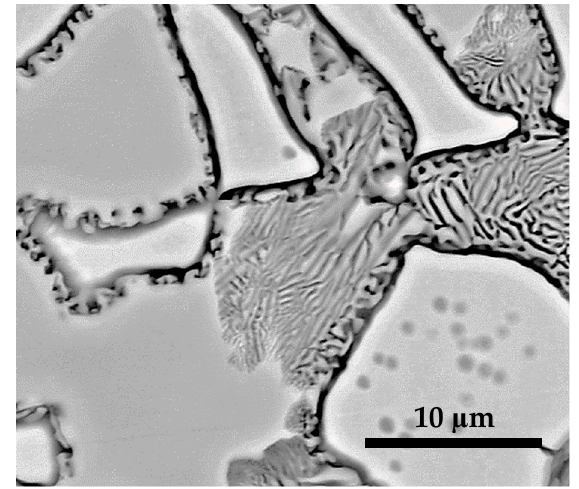
Figure 11. BSE micrographs of S1050a4 higher magnification.